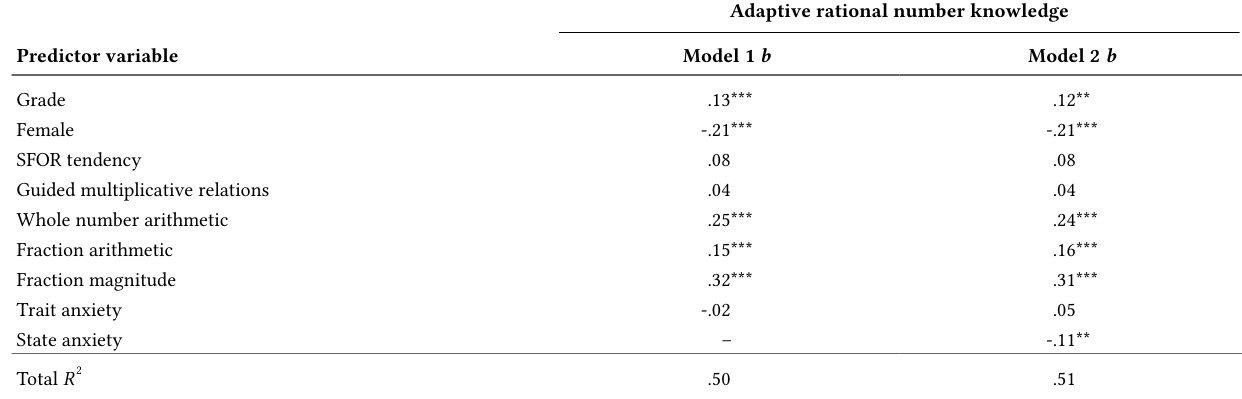
Hierarchical Regression Analysis Examining Factors Related to Adaptive Rational Number